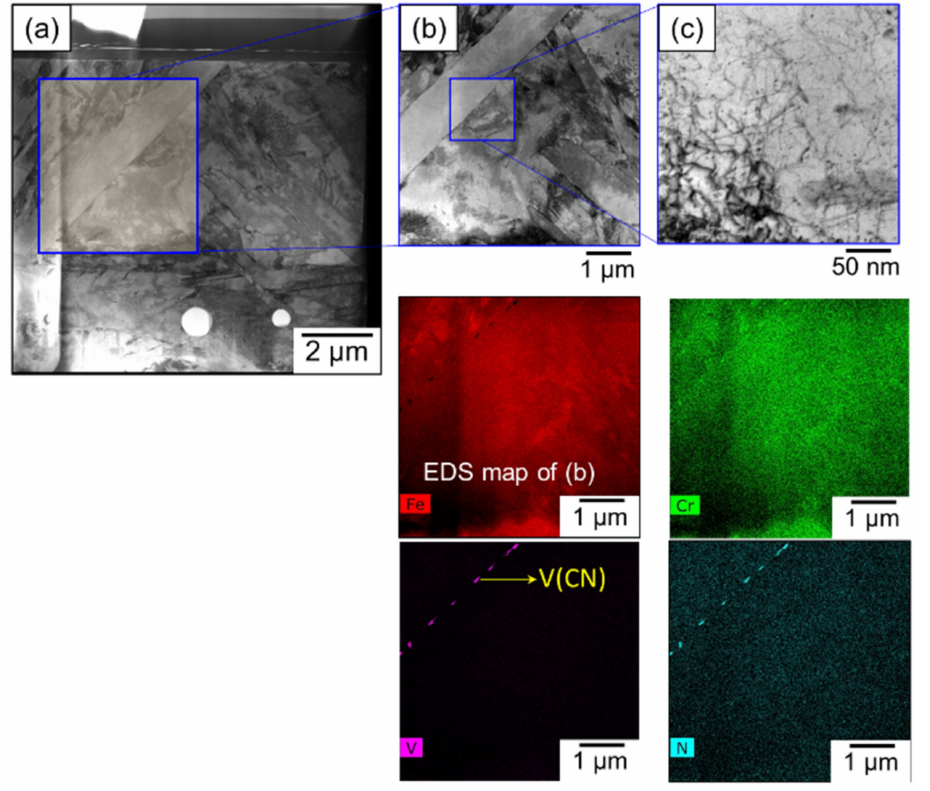
Figure 6. STEM micrographs ( a – c ) and EDS maps showing the absence of precipitates in the as- fabricated